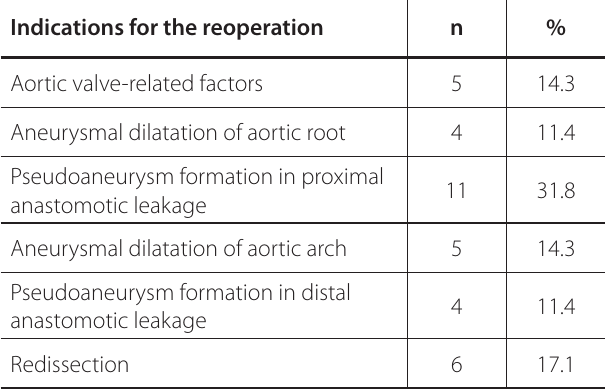
Table 3 . Indications for the reoperation.